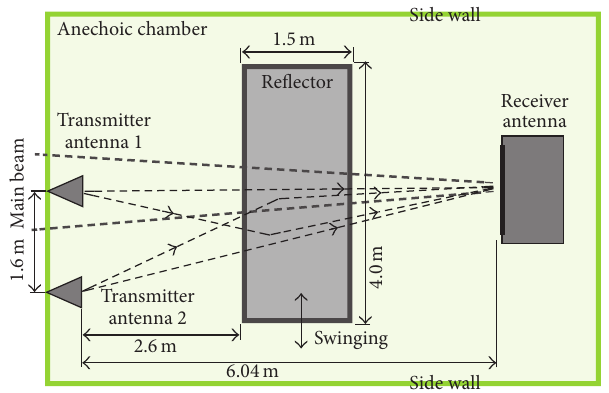
Figure 4: Top view of transmitter and receiver antennas and the reflector in the anechoic chamber. The drawing is not to scale.